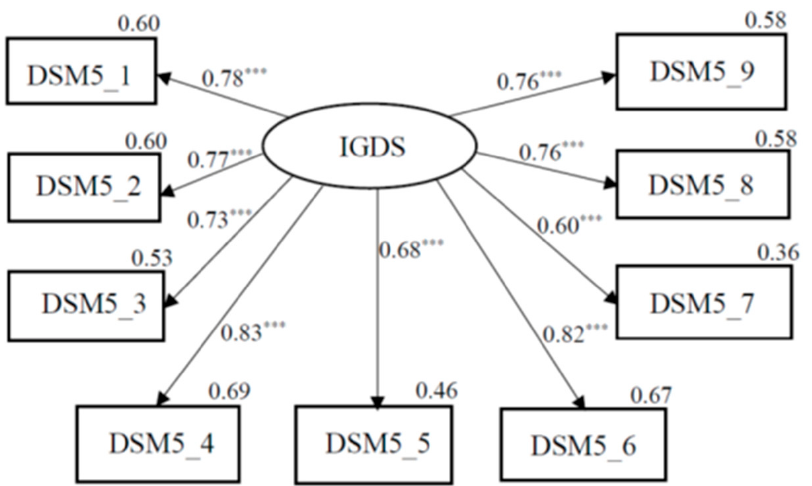
Figure 1. One-factor confirmatory factor analysis (CFA). Circles represent unobserved latent variables. Rectangles represent observed measured variables. Values are standardized path coefficients. The squared multiple correlation (R 2 ) value for the dependent variable appears above its rectangle. *** p < 0.001.